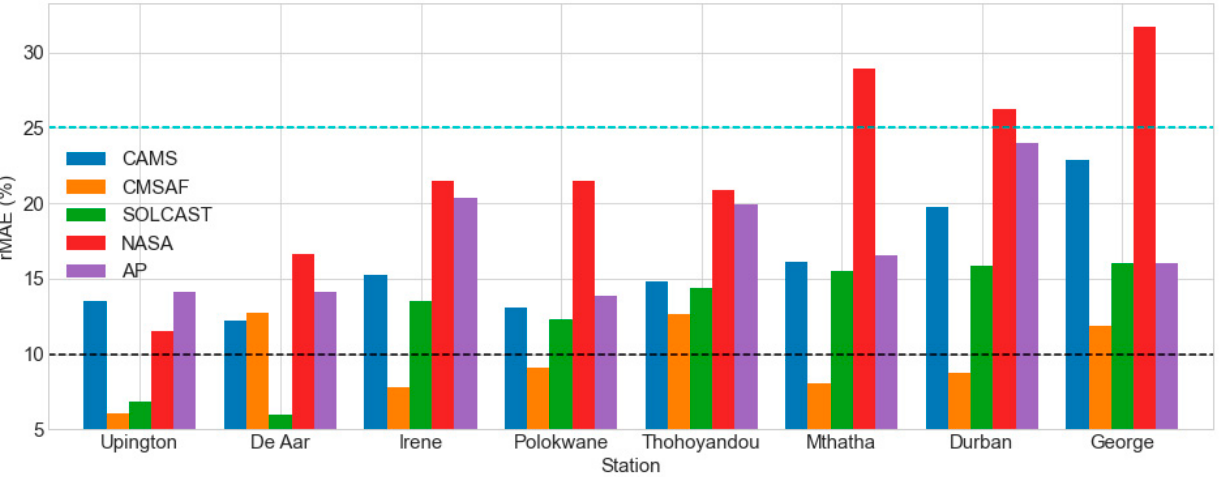
Figure 11. The daily rMAE of the estimated GHI datasets under overcast-sky conditions. Table 6 presents the correlation coefficient (R 2 ) findings under overcast skies. The CMSAF dataset indicated a high correlation at Upington (0.988), Irene (0.981), Mthatha (0.979), and Durban (0.976), but only a moderate correlation at George (0.968), De Aar (0.959), Polokwane (0.962), and Thohoyandou (0.942). The SOLCAST dataset demonstrated a high correlation at De Aar (0.982) and Upington (0.983), as well as a moderate correlation at Durban (0.925), Thohoyandou (0.957), and Mthatha (0.934). The SOLCAST dataset performed poorly in Polokwane (0.913), George (0.918), and Irene (0.936). The CAMS dataset indicated reasonable correlation at six stations, with R 2 ranging from 0.923 (at Durban) to 0.944 (at Mthatha), but weak correlation at De Aar (0.908) and Polokwane (0.907). The AP model shows weak correlation at all sites, with R 2 ranging from 0.812 (at Thohoyandou) to 0.912 (at Upington). The NASA SSE showed an excellent correlation at Upington (0.942) but a weak correlation at the other stations, with R 2 ranging from 0.737 (at Polokwane) to 0.863 (at Irene). Table 6. The daily average observed GHI (W/m 2 ) and correlation (R 2 ) of the estimated datasets against observed GHI under overcast-sky conditions. Green indicates the best (R (cid:2870) > 0.975 ), blue indicates the intermediate ( 0.925 ≤ R (cid:2870) ≤ 0.975 ), and yellow indicates the poor relationship (R (cid:2870) < 0.925) . Station MEAN CAMS CMSAF SOLCAST NASA Ångström–Prescott